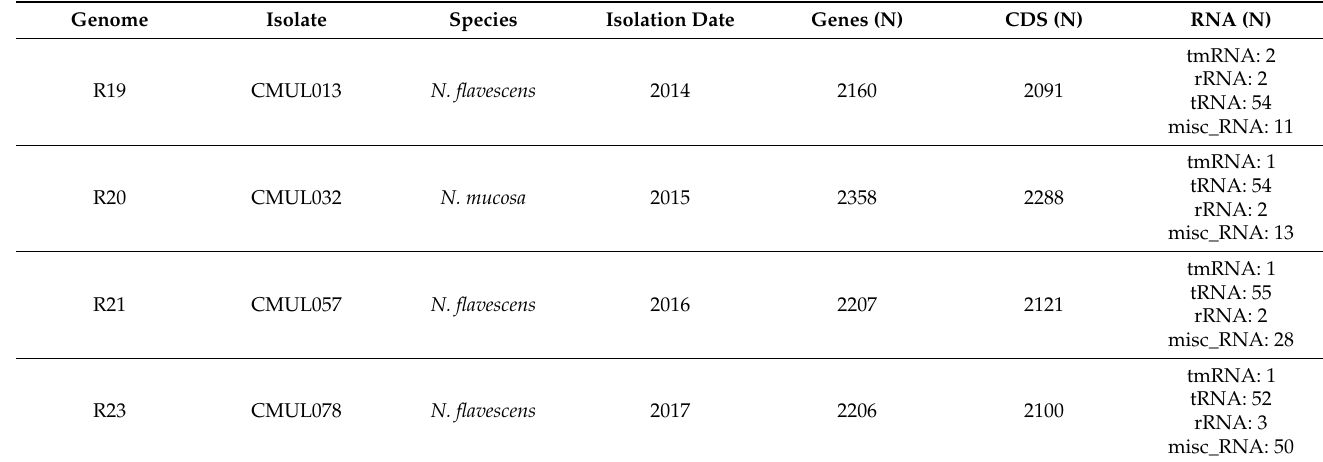
Table 1. Genomic annotation of the four Lebanese Neisseria